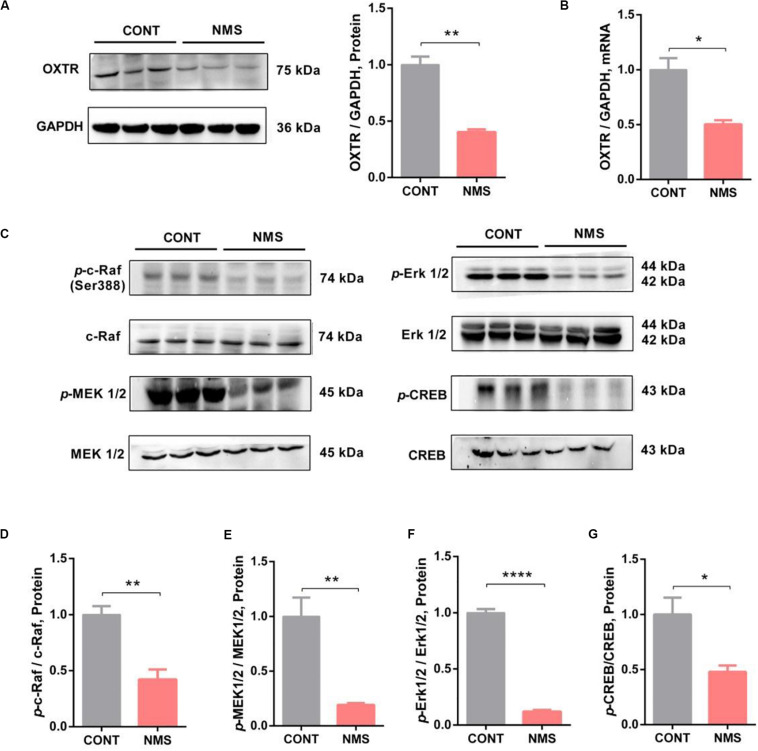
OXTR expression was downregulated with inhibition of Erk/MAPK signaling in long-term NMS rats. (A) Immunoblots and quantification analysis of the protein level of OXTR in mPFC from CONT and long-term NMS rats (two-tailed unpaired t-test, t4 = 7.869, P = 0.0014, **P < 0.01). (B) Quantitative real-time PCR data on mRNA level of OXTR in PFC from CONT and NMS rats (two-tailed unpaired t-test, t4 = 4.422, P = 0.0115, *P < 0.05). (C–G) Immunoblots and quantification analysis of the protein levels of p-c-Raf, p-MEK 1/2, p-Erk 1/2, and p-CREB in mPFC from CONT and long-term NMS rats (two-tailed unpaired t-test; t4 = 4.958 [p-c-Raf], P = 0.0077; t4 = 4.687 [p-MEK1/2], P = 0.0094; t4 = 25.46 [p-Erk1/2], P < 0.0001; t4 = 3.200 (p-CREB), P < 0.0329; **P < 0.01, ****P < 0.0001, *P < 0.05). Data are represented as mean ± SEM (n = 3 in each group).